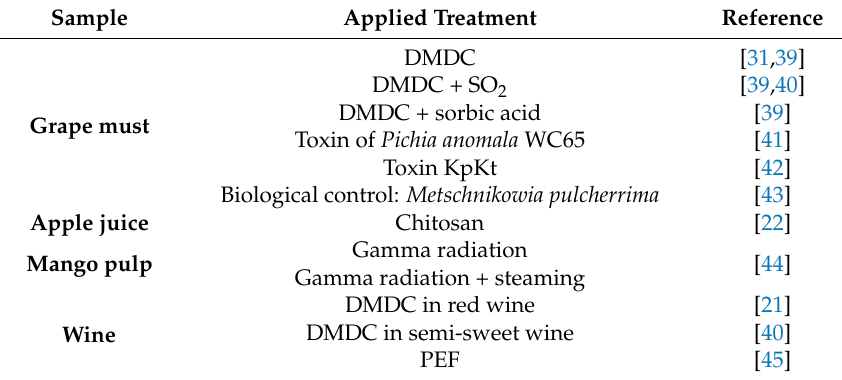
Table 1. Applied treatments for the control of Saccharomycodes ludwigii